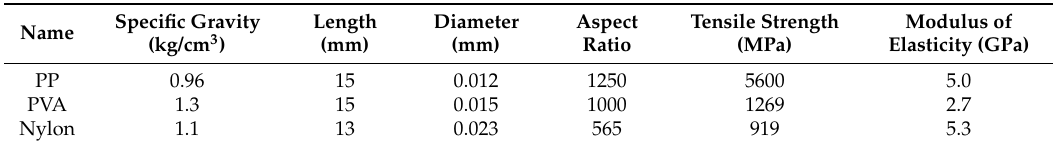
Table 2. Characteristics of fibers.